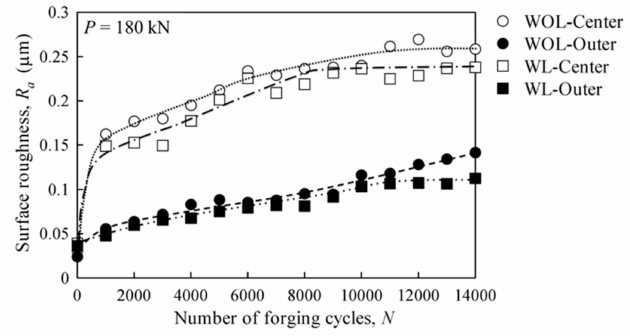
Figure 7. Average arithmetic surface roughness at the center and the average of outer areas by the number of forging cycles, for the 180 kN forging load. (WL—With Lubrication, WOL—Without